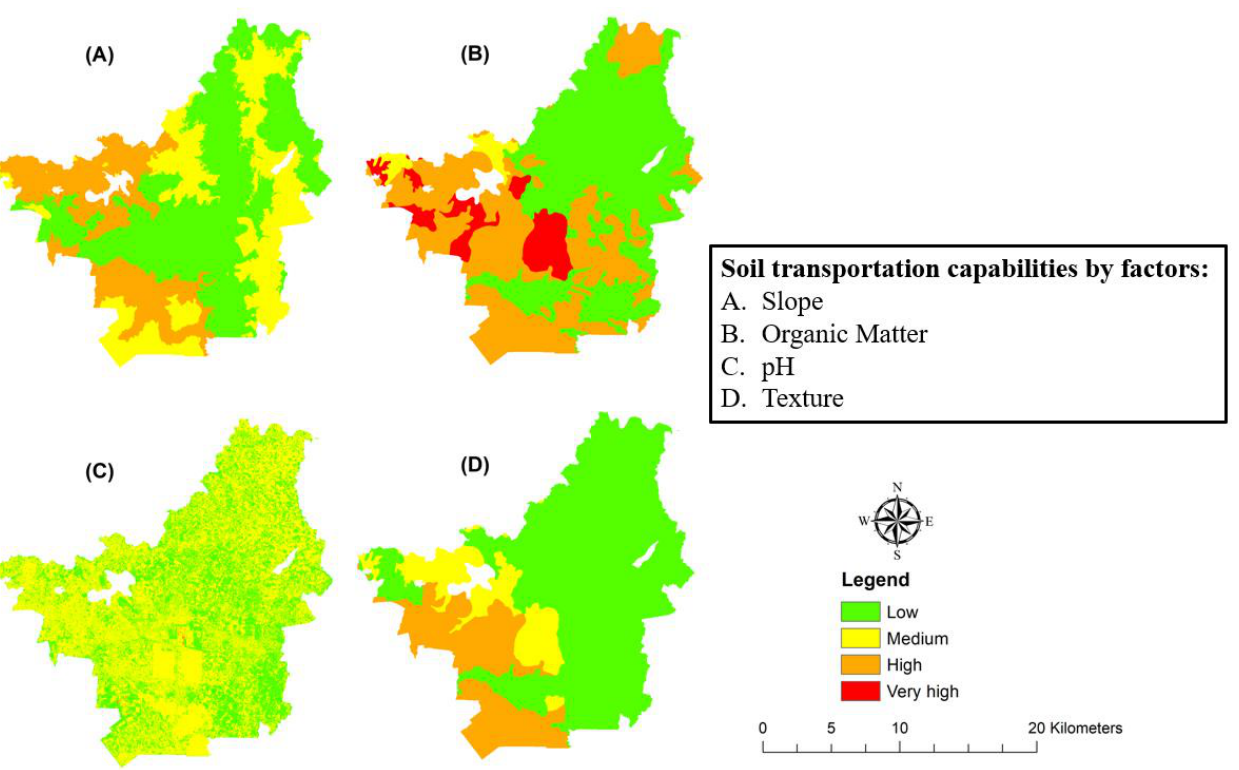
Figure 6. Maps show the levels of retention capability of Al 3+ of each criterion.